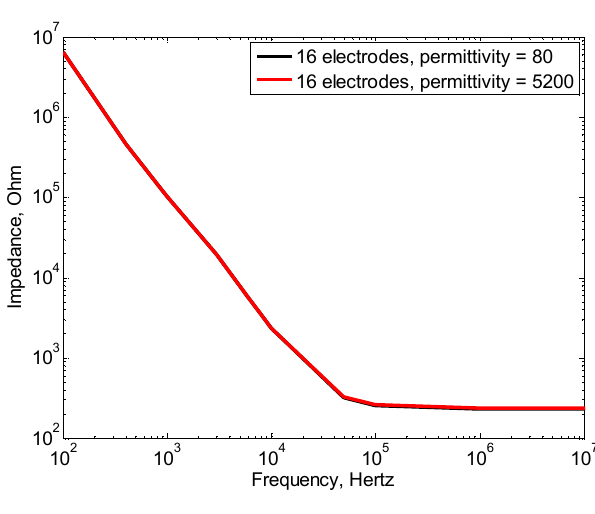
Fig. 10: Simulated response of interdigital biosensor with 16 electrodes, by changing the permittivity of the blood medium (layer 4). Electrical impedance simulated for two different permittivities, 80 and 5200,